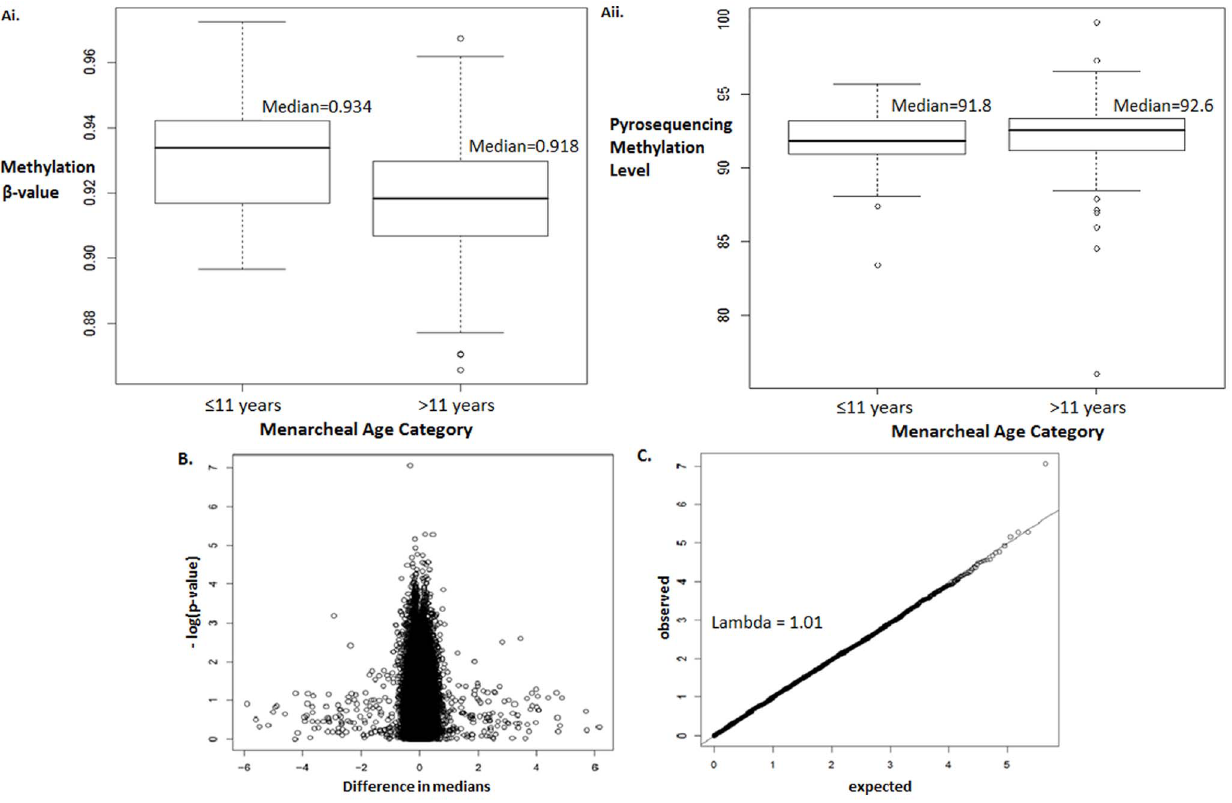
Figure 2. Analysis of SMAD6 cg01339004 probe methylation. Ai: Boxplot of b -value methylation of cg01339004 probe as measured with Illumina 450 k beadchip in Stage 2. Aii: Boxplot of methylation level of cg01339004 probe as measured with bisulphite pyrosequencing in Stage 3. B: Volcano plot: Difference in median methylation between the two menarcheal age groups ( . 11 (n=268) vs. # 11 years, (n=62), against the –log(P- Value) of a linear regression analysis with methylation as a continuous outcome (M-values) and age at menarche ( . 11 vs. # 11 years) as a categorical exposure, adjusting for age, case-control status, and chip position. C. Q-Q plot on P-values from a linear regression analysis with methylation as a continuous outcome (M-values) and age at menarche ( . 11 vs. # 11 years) as a categorical exposure, adjusting for age, case-control status, and chip position.